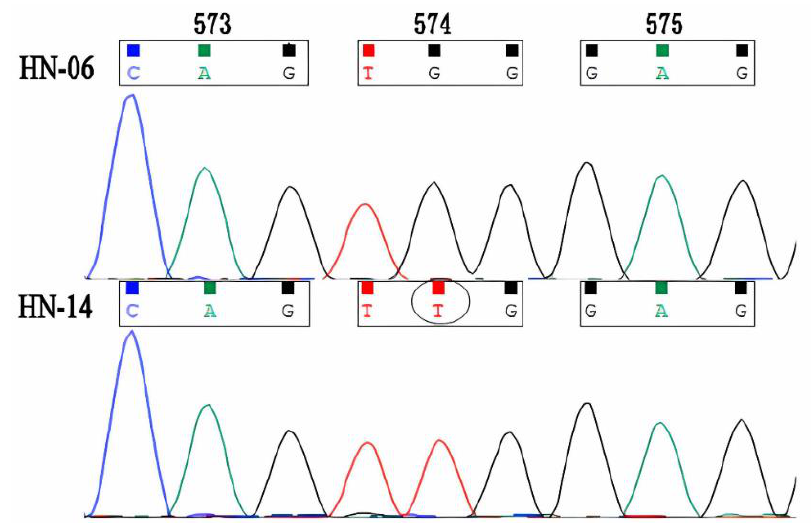
Figure 2. Spectrogram of sequence of ALS from resistant (HN-14) and susceptible (HN-06) black-grass. HN-14 is Trp-574-Leu homozygous mutation, and HN-06 is no mutation.